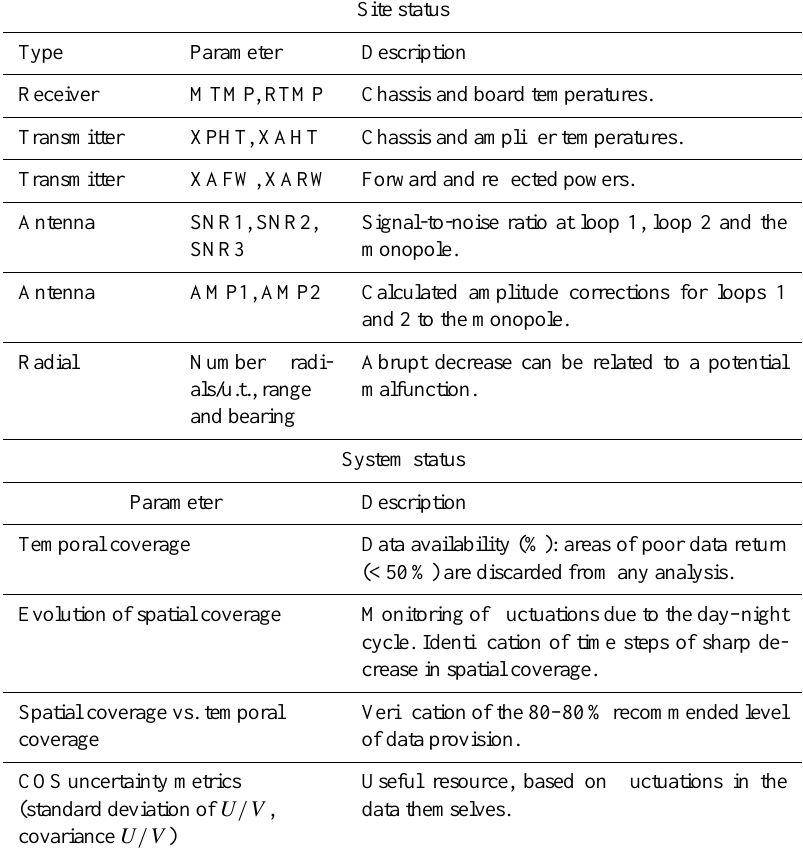
Table 1. Diagnosed parameters used to operationally monitor Ebro delta HF radar status in real time. The HF radar system’s performance is routinely evaluated through the analysis of the indicators listed below at different frequencies